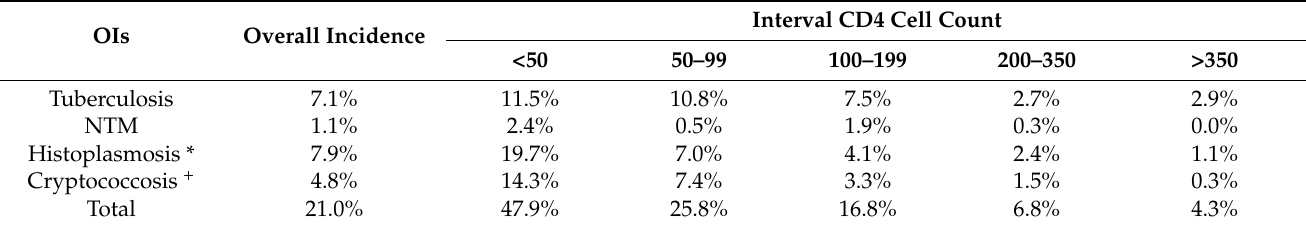
Table 2. Opportunistic infections incidence stratified by CD4 cell